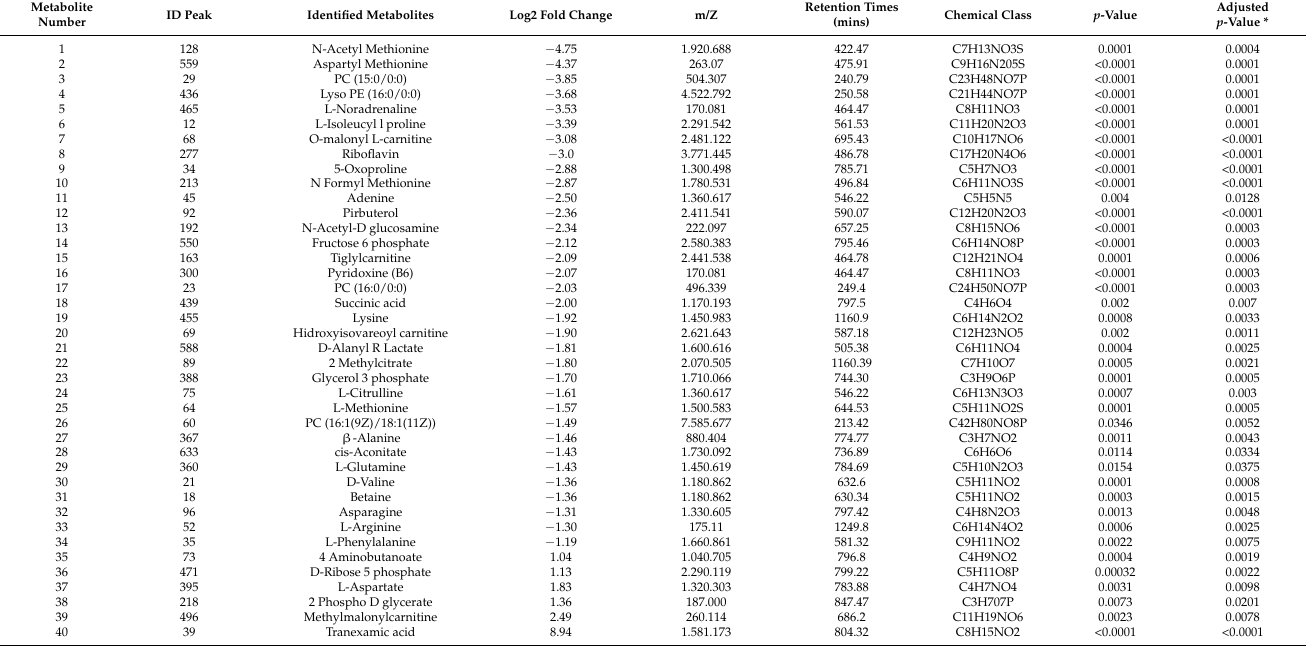
Table 1. Identity of metabolites with significantly different abundance between CCC patients and healthy donors.